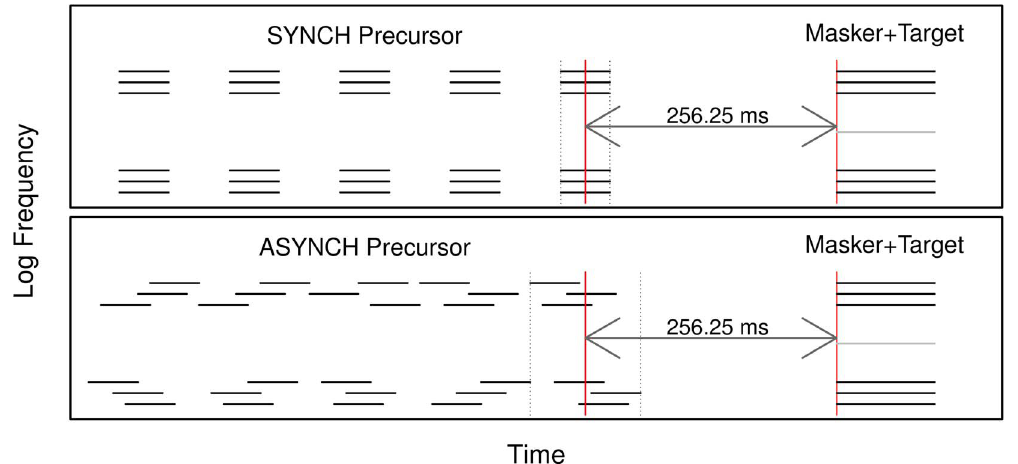
Figure 1. Illustration of the stimuli used in experiment 1. Listeners had to detect a 100-ms target (gray line) embedded in a 100-ms multitone masker (background). The masker-plus-target mixture could be preceded by five bursts of a synchronous precursor (top panel), five bursts of an asynchronous precursor (bottom panel), or silence (not shown). As indicated by the arrows, the time interval between the midpoint of the last precursor burst and the beginning of the masker-plus-target mixture was the same in the SYNCH and ASYNCH conditions.